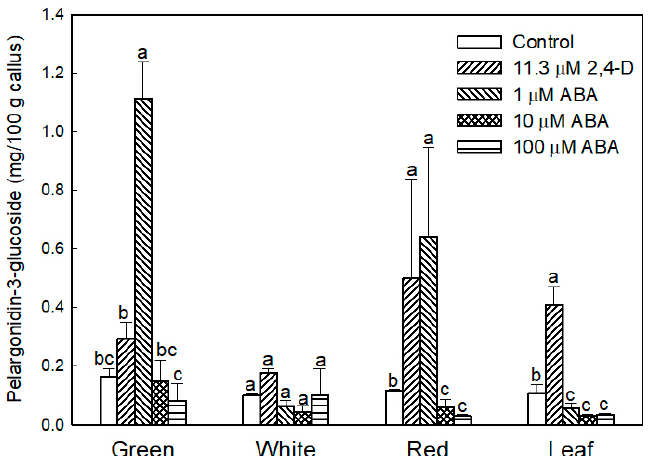
Figure 5. Anthocyanin production in calli obtained from strawberry leaf and fruits at different developmental stages after culturing for 2 weeks in N 30 K medium with 2,4-D or ABA in the presence of light. Control: callus incubated in the absence of growth regulators. Within each callus line, columns with different letters indicate significant differences by Kruskal–Wallis test at p = 0.05.